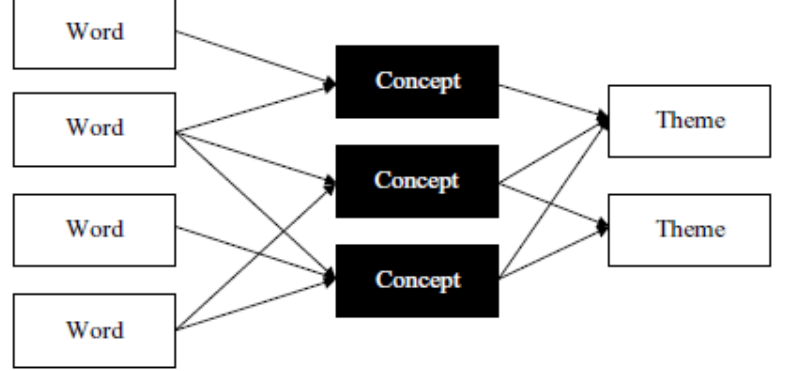
Figure 3. The basic model of the semantic configuration extraction in Leximancer. Source: adopted from Crofts and Bisman (2010).